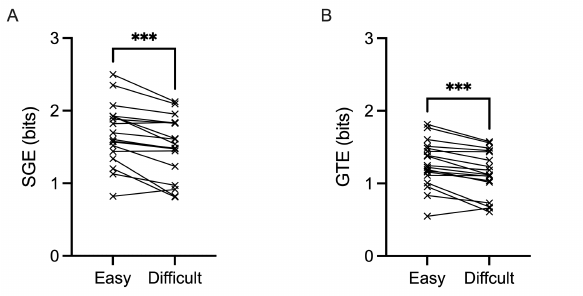
Figure 5. Individual data points for stationary gaze entropy (SGE) (bits) (A) and gaze transition entropy (GTE) (B) are demonstrated for easy and difficult conditions. Error bars repre- sent SEM. * p ≤ 0.05, ** p ≤ 0.01, *** p ≤ 0.001, **** p ≤